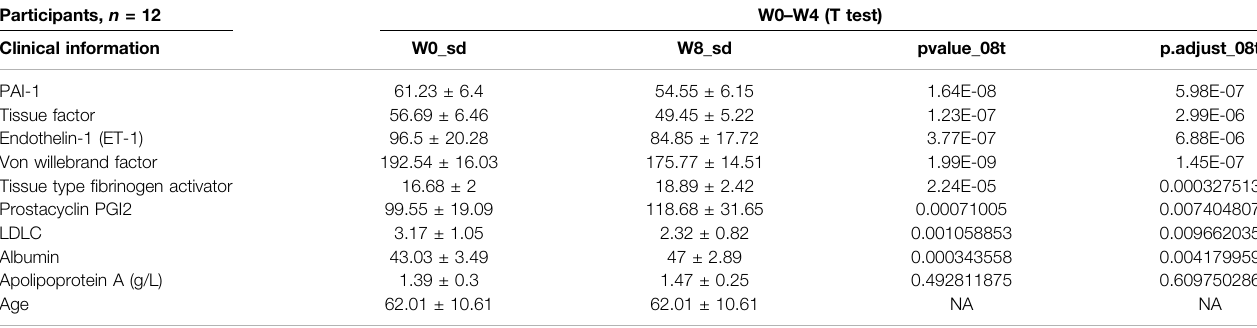
TABLE 2 | Clinical information for patients treated with GLP-1 from W0 to